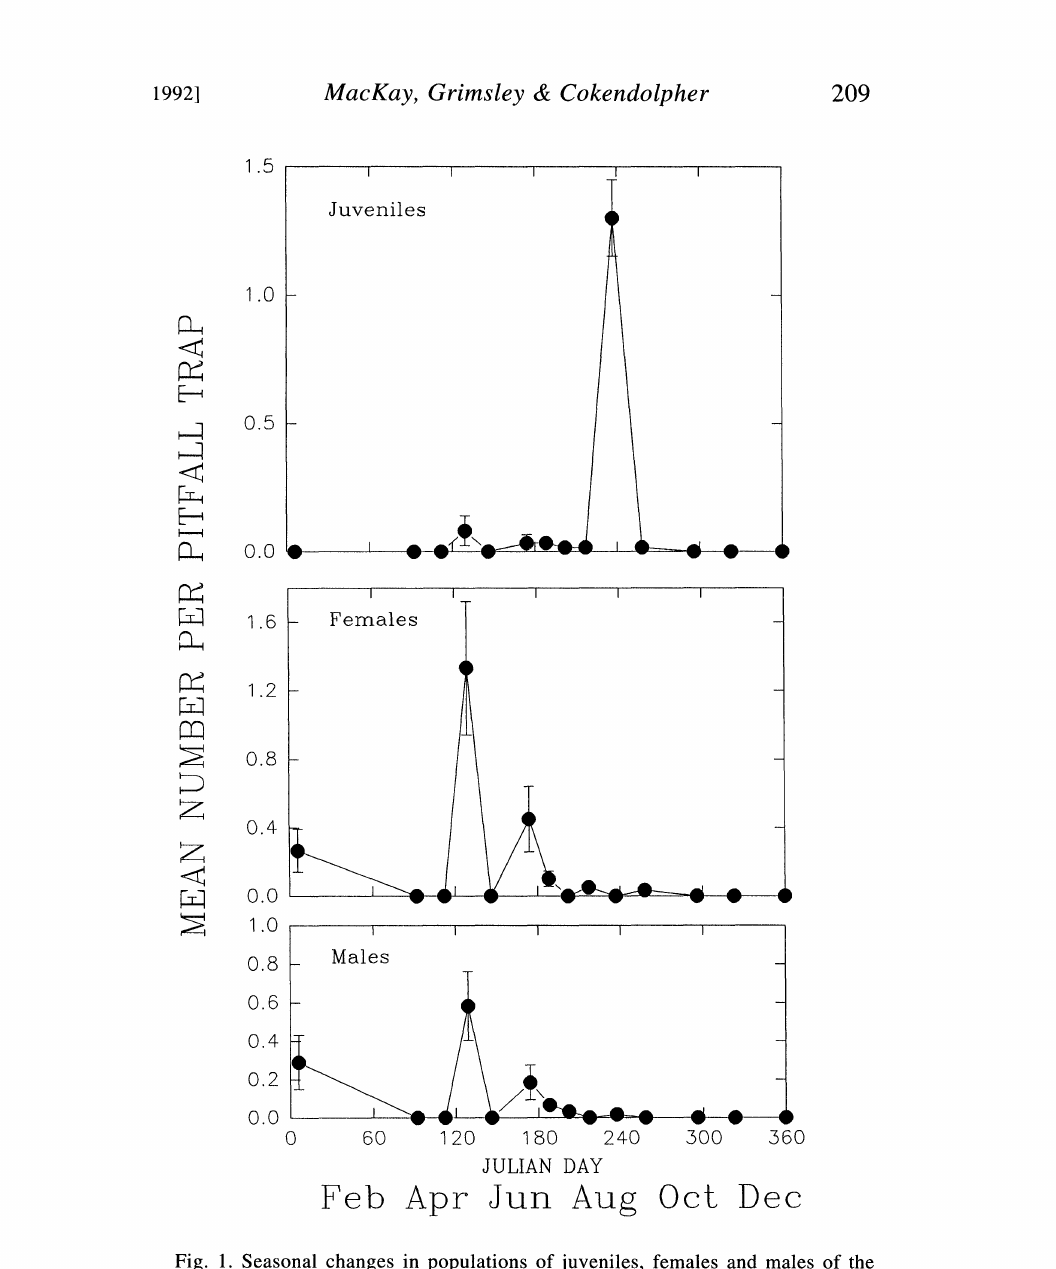
Fig. 1. Seasonal changes in populations of juveniles, females and males of the harvestman, Trachyrhinus marmoratus, in western Texas during 1991. Julian dates are indicated. The error bars are standard errors of the